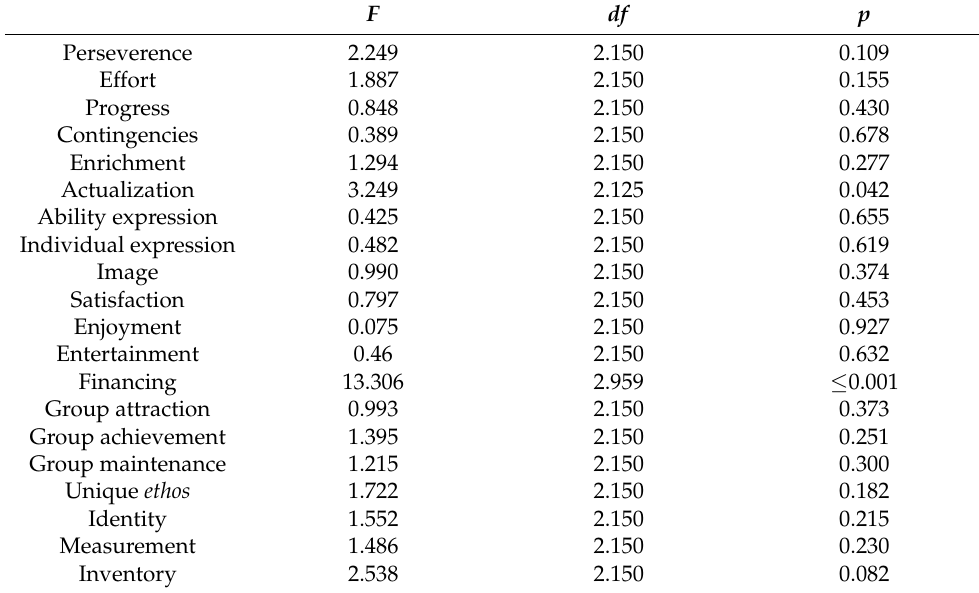
Table 7. Summary of one-factor ANOVA: Serious Leisure Inventory and Measure (SLIM) considering age. F df